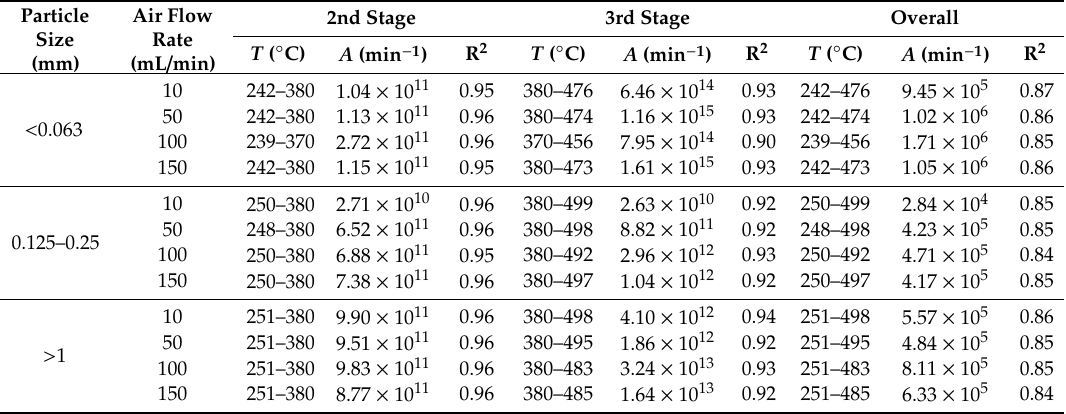
Table 7. Temperature intervals, correlation coe ffi cients, and pre-exponential factors for each stage of combustion for all particles studied under di ff erent air flow